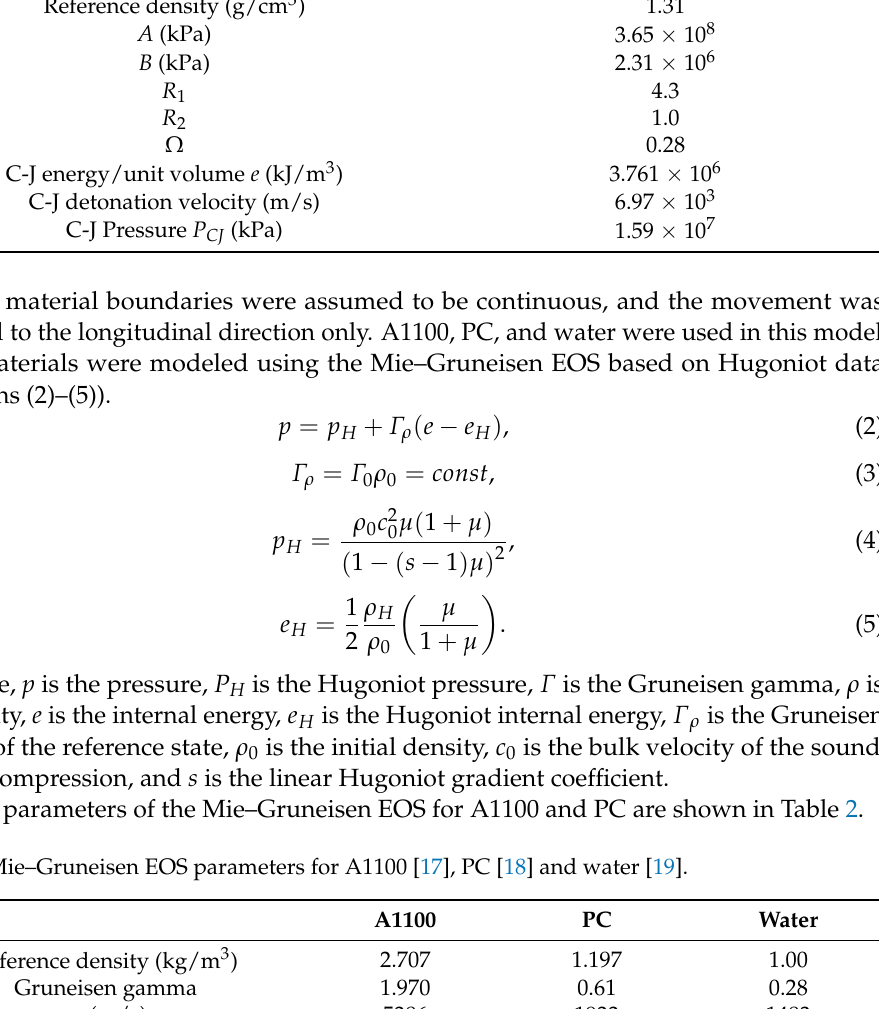
Table 1. Jones–Wilkins–Lee (JWL) equation of state (EOS) parameters for the SEP explosive [16]. Parameter